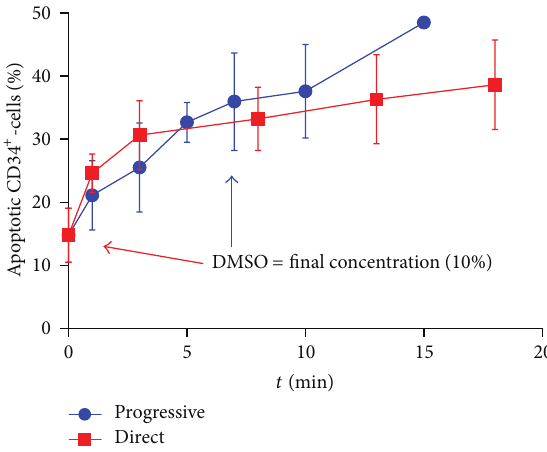
Figure 7: The impact of DMSO on apoptosis of CD3 4 + cells after eitherprogressive(bluecircles)ordirect(redsquares)addition;cord blood units ( 𝑛 = 3 ). Progressive addition leads to a constant loss of viability over time, while direct addition of DMSO resulted in an increased initial loss but slower progression of